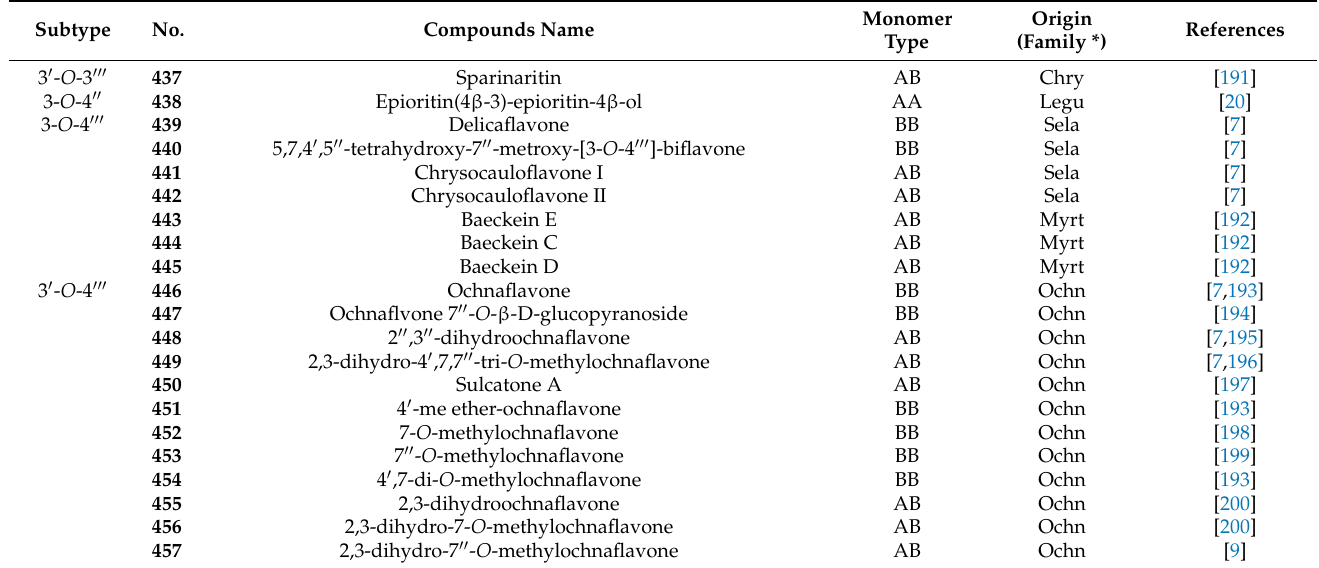
Table 9. The C-linear fragment-C subtypes of